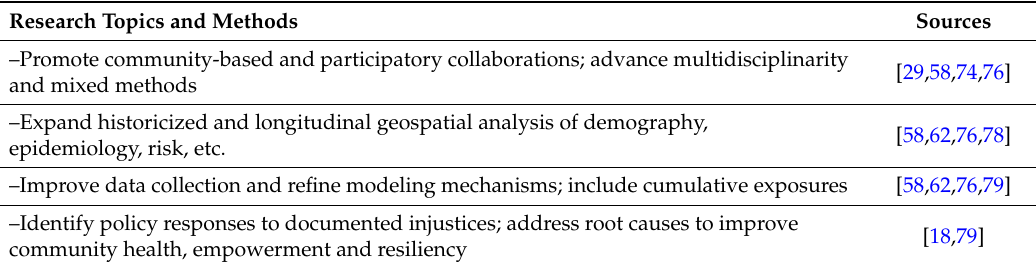
Table 9. A participatory energy justice research